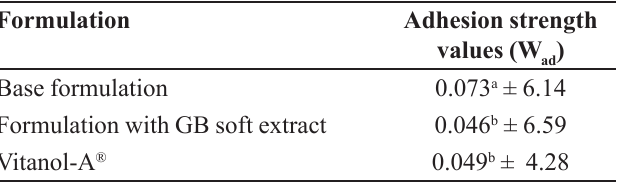
TABLE VI - Adhesion strength values (Wad) for the formulations containing or not the GB soft extract. The results are expressed as mean and standard